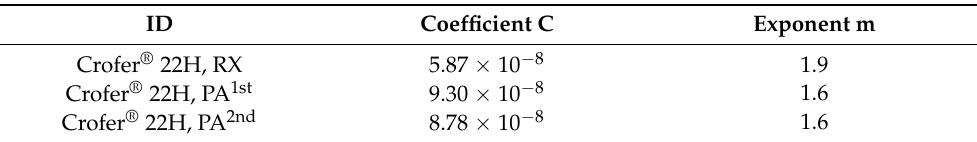
Figure 9. ( a ) Paris and ( b ) fifth-degree polynomial fit to the crack growth curves of precipitation- annealed Crofer ® 22H (PA) (f: 20 Hz, T: 650). Table 4. Nominal fatigue crack growth parameters (Paris fit) in dependence of annealing state (f = 20 Hz, T: 650 °C).